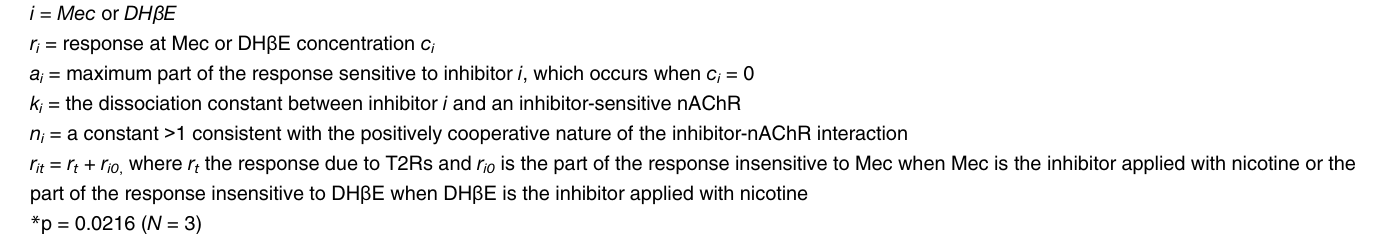
Table 2. Fitting parameters for the 10 mM nicotine CT response in the presence of increasing concentrations of DH β E and Mec using Eq 2. Inhibitor ( i